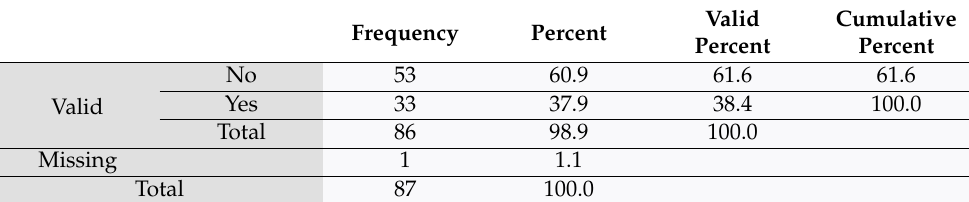
Table 8. Do you feel TMJ/orofacial pain is correlated with what you eat?